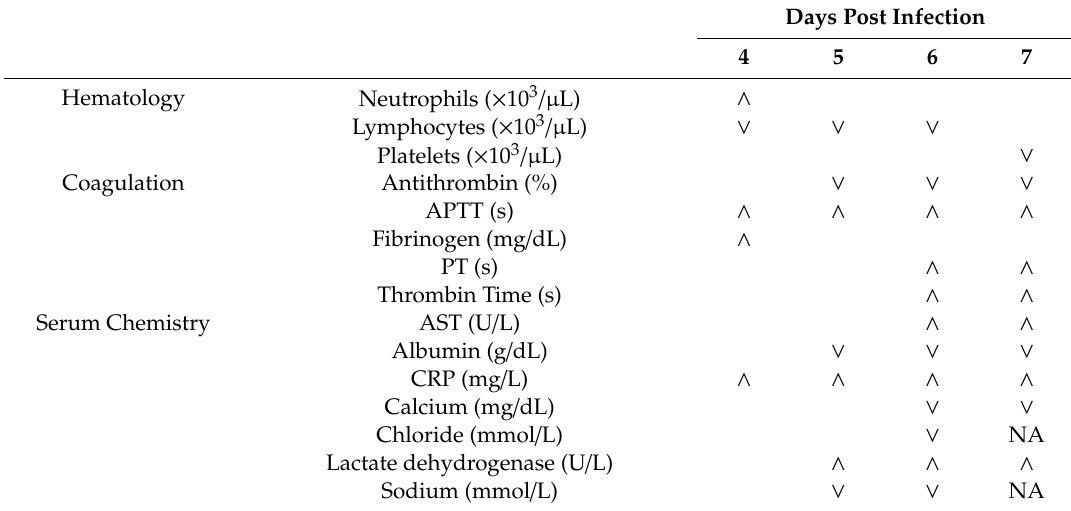
Table 3. Timing of uniform, significant, and EBOV-specific clinical pathology